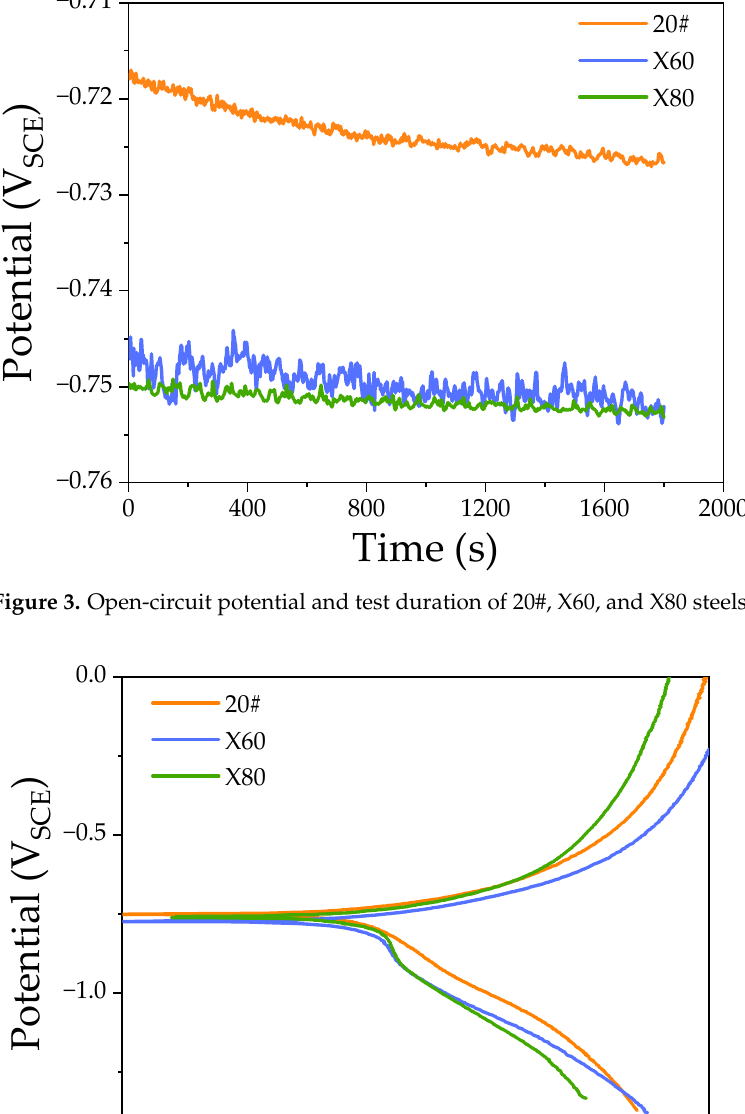
Figure 4. Polarization curve of 20#, X60, and X80 steels in NS4 solution. Table 2. Electrochemical parameters of 20#, X60, and X80 steels in NS4